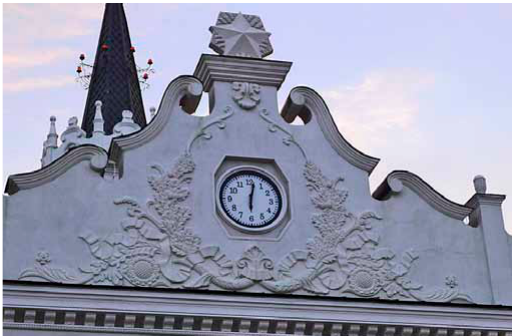
fig. 22. The motive of sunflowers in the palace of the Char- kov airport (the old corpus), ukraine. r. Čepaitienė photo